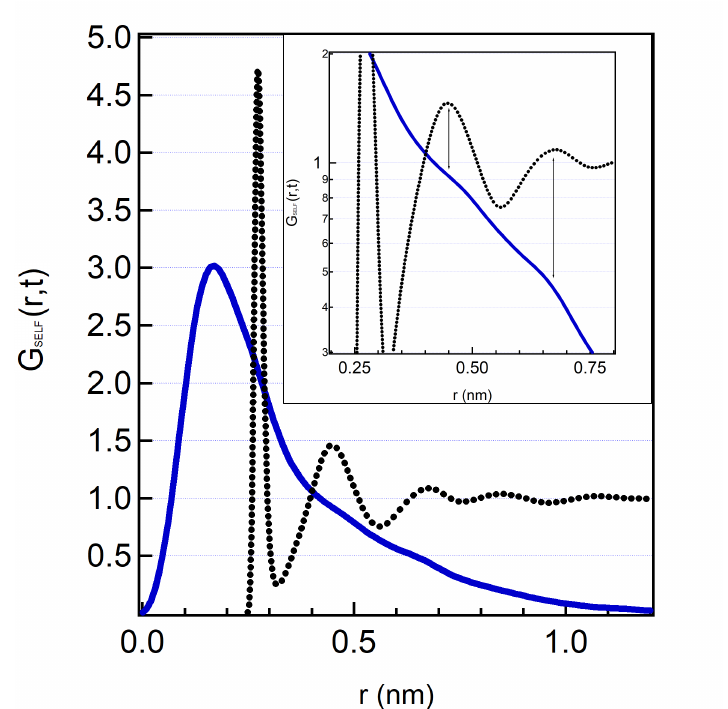
Figure 4. SVHF (blue continuous line) for hydration water at T = 200 K for a long correlation time, t = 50 ns. In this curve it is evident the presence of hopping phenomena: the shoulders that can be seen in the curve are due to the jumps of the particle out of the molecular cage. The dashed line represents the radial distribution function of the oxygens of bulk water: the shoulders correspond to the location in space of the second and third shells around the particle, as best evident in the inset, where we show a blow-up of the same curves in semi logarithmic